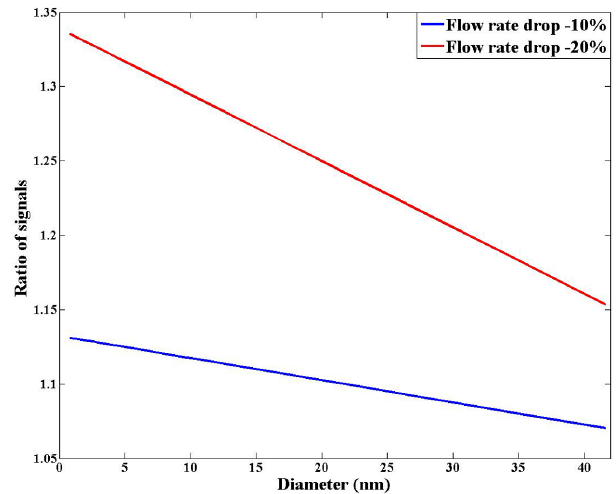
Fig. 2. Ratio of raw signals during normal flow rate to reduced flow rate. The peak signal and both adjacent signals from the electrome- ters were included in the